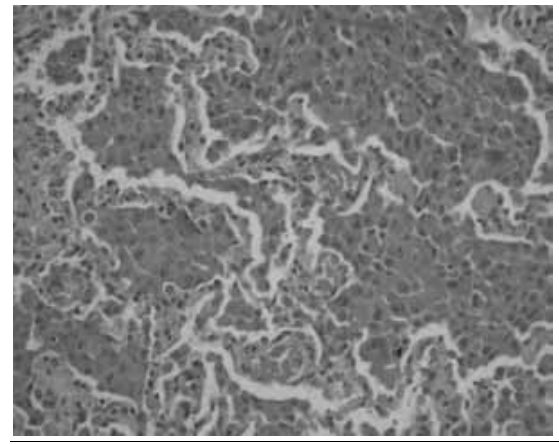
figurE 5 – IPH: coarse granules of brown hemosiderin are contained within the cytoplasm of numerous macrophages that fill various alveolar spaces (HE 200×) IPH: idiopathic pulmonary hemorrhage; HE: hematoxylin and eosin.